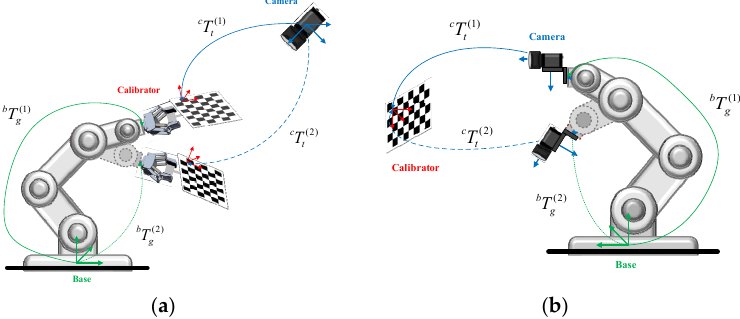
Figure 1. Two hand–eye calibration modes: ( a ) Eye-to-hand; ( b ) Eye-in-hand. Where Base represents the base coordinate system of the robot; Camera represents the camera coordinate system; and Calibrator represents the calibration board.